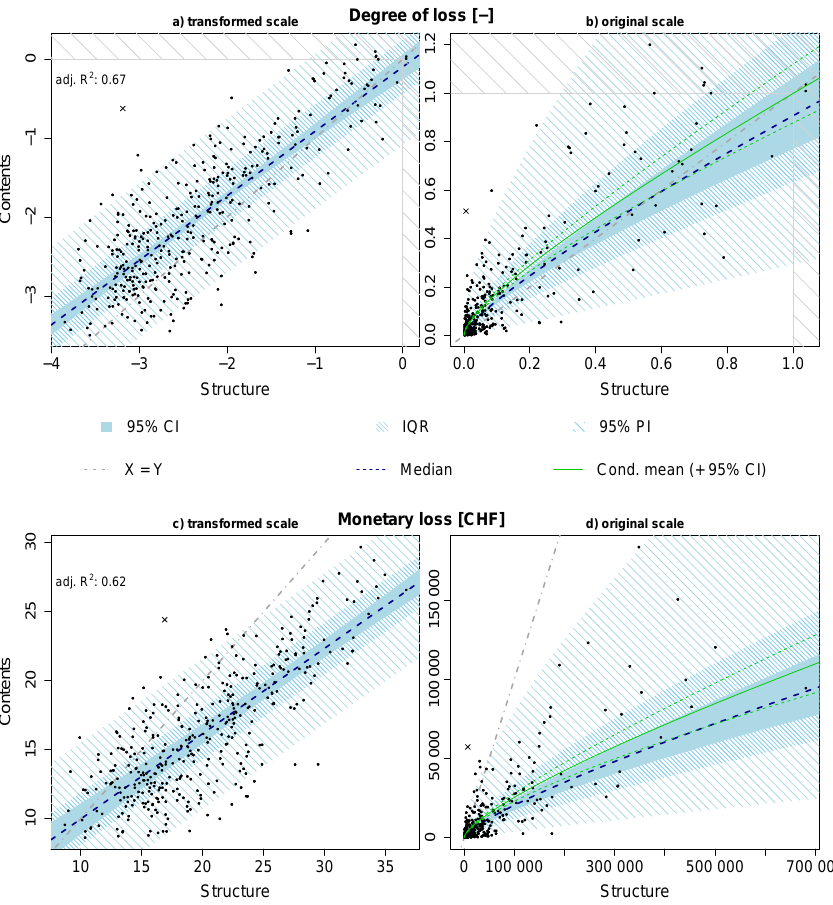
Figure 3. Loss models based on degrees of loss ( a , b ) and monetary loss in CHF ( c , d ). In plots ( a , c ), the models based on transformed input values are presented, whereas in ( b , d ) the model results are shown on the original scale after back-transformation. CI: Confidence Interval; IQR: Inter-Quartile Range; PI: Prediction Interval. Note that the mean in plots ( a , c ) coincides with the median. Cross symbol: Outlier excluded before model